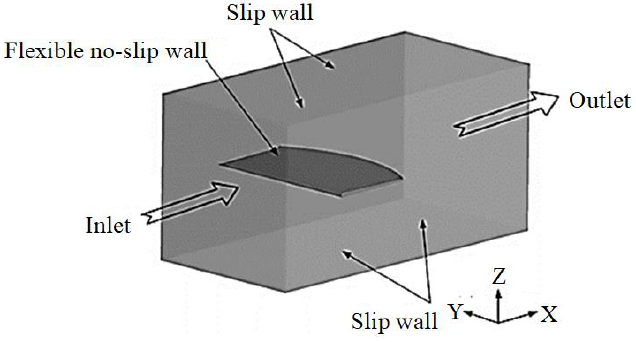
Fig. 1. Computational domain in SolidWorks